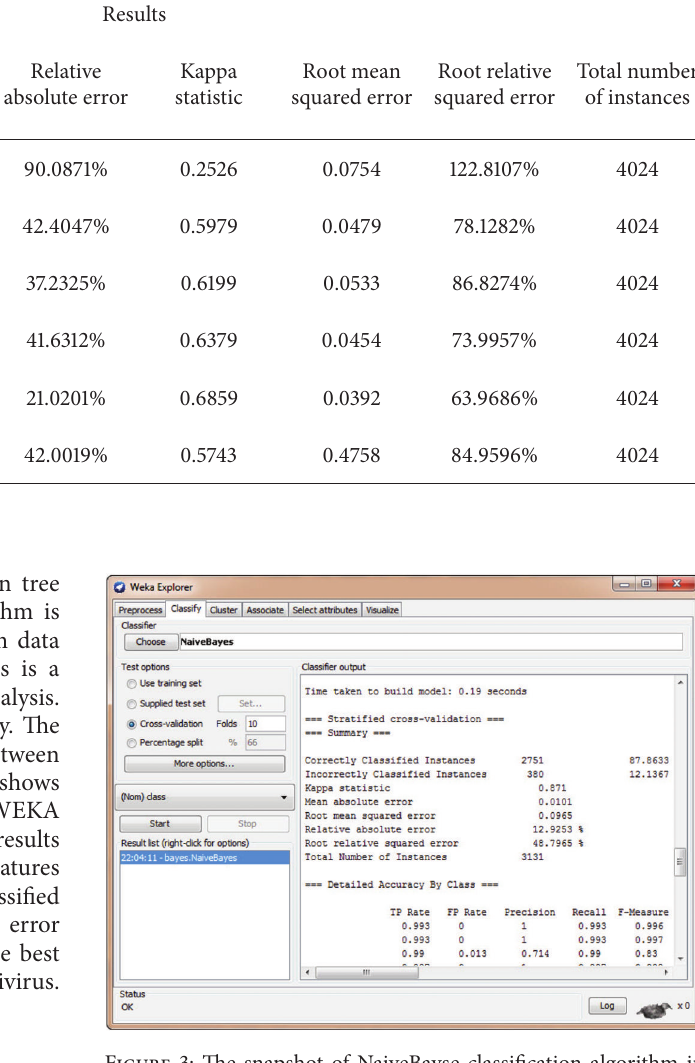
Figure 3: The snapshot of NaiveBayse classification algorithm in